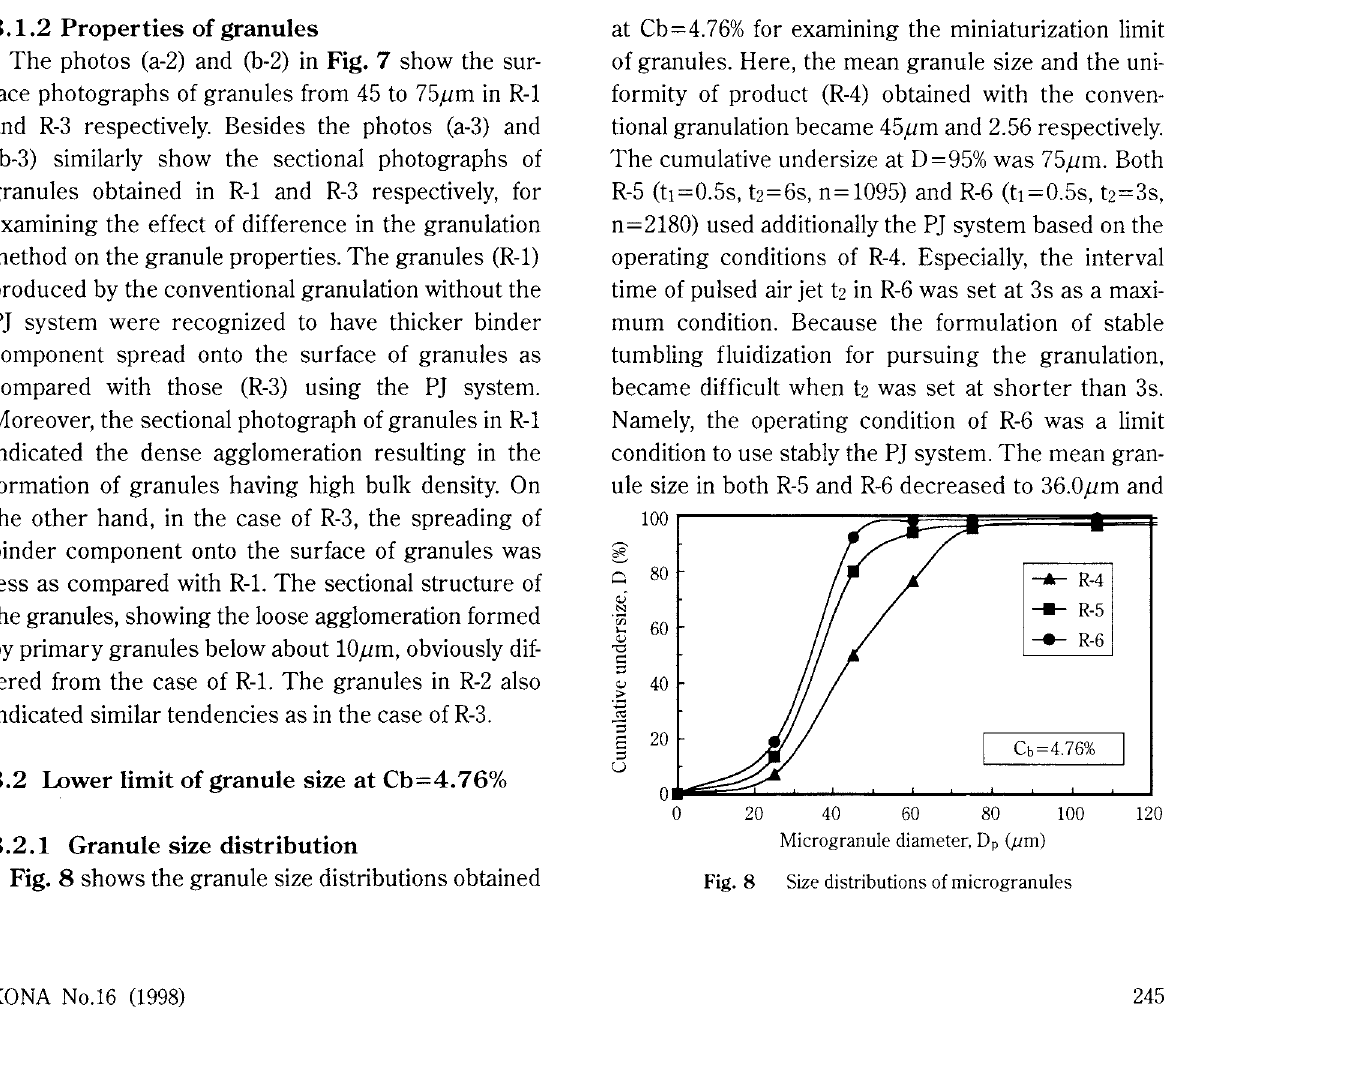
SEM photographs of micro granules obtained in R-1 and R-3 ( ,.___.; scale) (a-1); R-1. Products under 25Jim